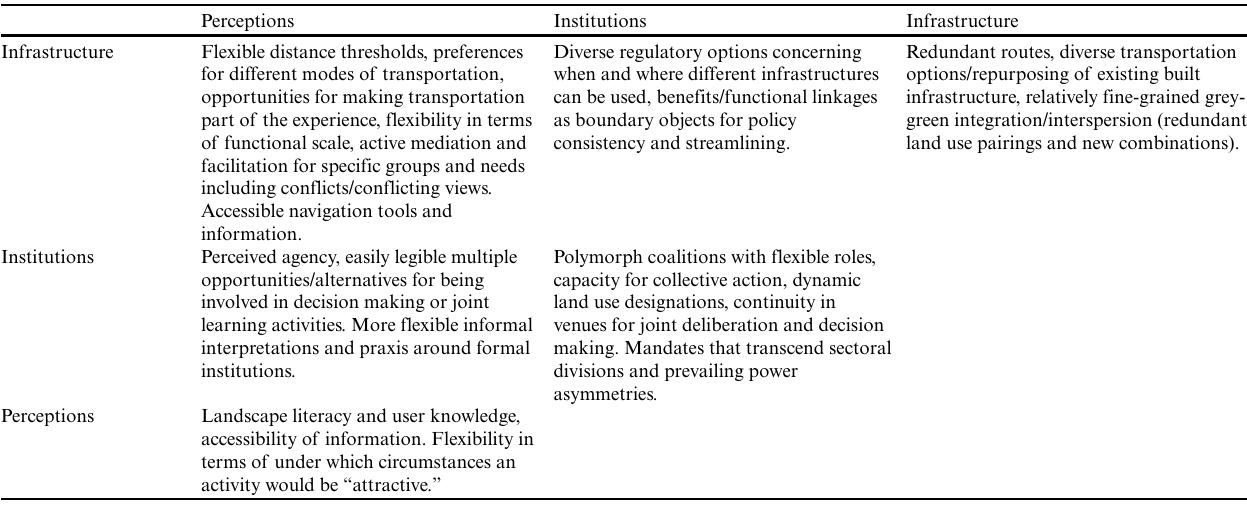
Table 3 . Emergent key issues (within and across filters) for building resilience around flows of green and blue infrastructure (GBI) benefits applying a social-ecological-technological systems (SETS) perspective including human perceptions, institutions, and infrastructure contexts affecting